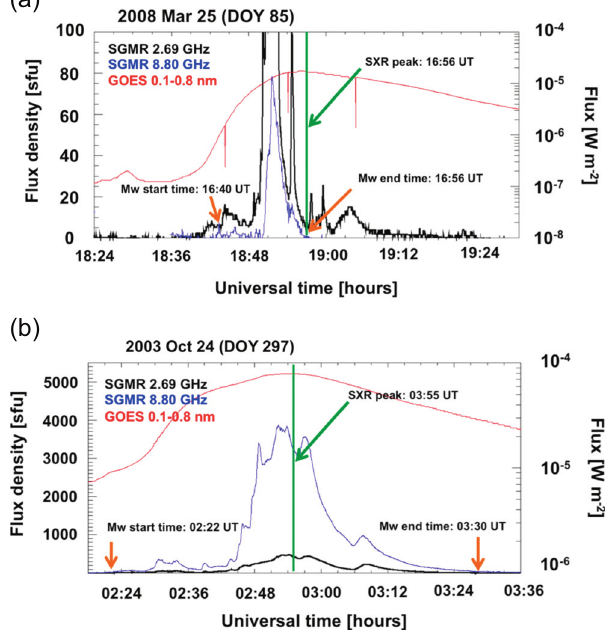
Fig. 2. Examples of time range selection for the fluence calculation. Black and blue curves are the microwave emissions at 2.69 and 8.8 GHz, respectively, while the SXR burst is plotted in red. The orange arrows show the start and the end of the time interval for the fluence calculation. (a) End of the interval matches the peak of the SXR counterpart (green line). (b) The microwave fluence calculation is extended until the end of the non-thermal microwave burst